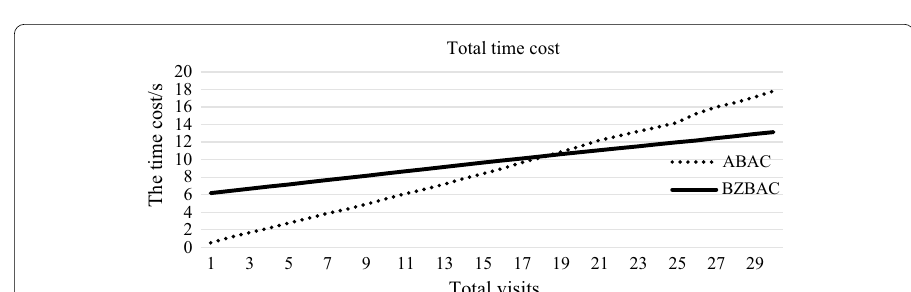
Fig. 5 Total time cost. The experimental results: It can be seen that at the beginning of the experiment, due to the need for the consensus time of blockchain and the generation time of zero-knowledge proof, the running time of BZBAC is much longer than that of Attribute-Based Access Control. However, with the increase in the number of tests, ABAC has been in a state of linear growth. Since BZBAC has completed the generation of ZKToken, subsequent access time is only spent on the verification of ZKToken, so the growth of running time is relatively flat. Although ABAC has a lower cumulative time consumption than BZBAC for previous visits, it gradually has a higher time consumption than BZBAC after the 19th of this access. Thus, the BZBAC model can improve access efficiency and reduce time cost in the case of multiple accesses. If only a few visits are made, the time cost of this model is still relatively high due to the need for trust setting. However, considering reality, users will often visit the same device multiple times rather than just several times. Also, compared with the time required for each visit, users are more inclined to prepare for the subsequent quick access by setting the first time for a longer time. Therefore, in general, the accumulated time cost of BZBAC is reduced and the user’s experience effect is